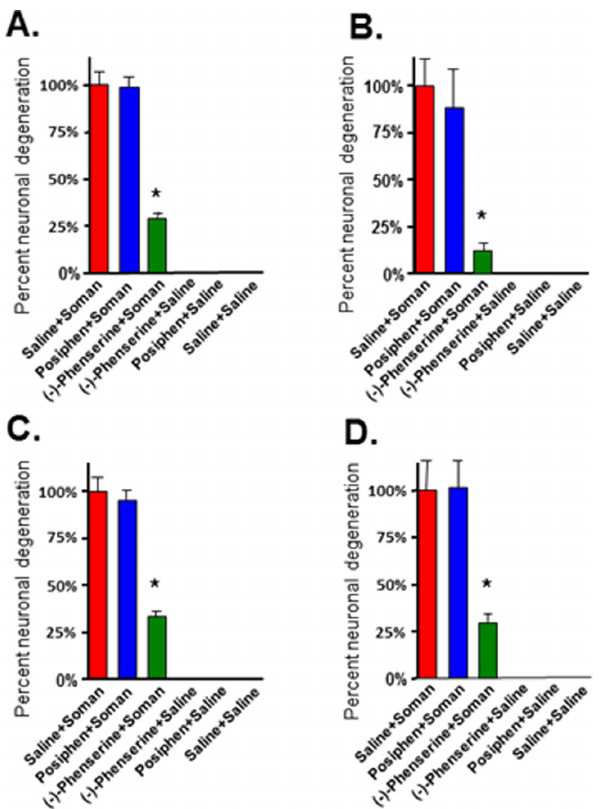
Figure 4. Administration of ( 2 )-phenserine injected intrave- nously 30 min prior to soman protects neurons against soman- induced neuronal cell death. Rats were pretreated with ( 2 )- phenserine, posiphen or saline, as indicated 30 min prior to soman. Slides from each brain region were randomly selected. Photographs were acquired from three representative fields per brain region per animal. The number of fluorescein-positive neurons was counted by an investigator that was blinded to the treatment. The bar represents the average percent neuronal cell death 6 SD in the pirform cortex (A), hippocampus (B), basolateral amygdala (C), cingulate cortex (D). n=6/ group. *p , 0.001 vs saline/soman by ANOVA + Tukey post hoc analysis.